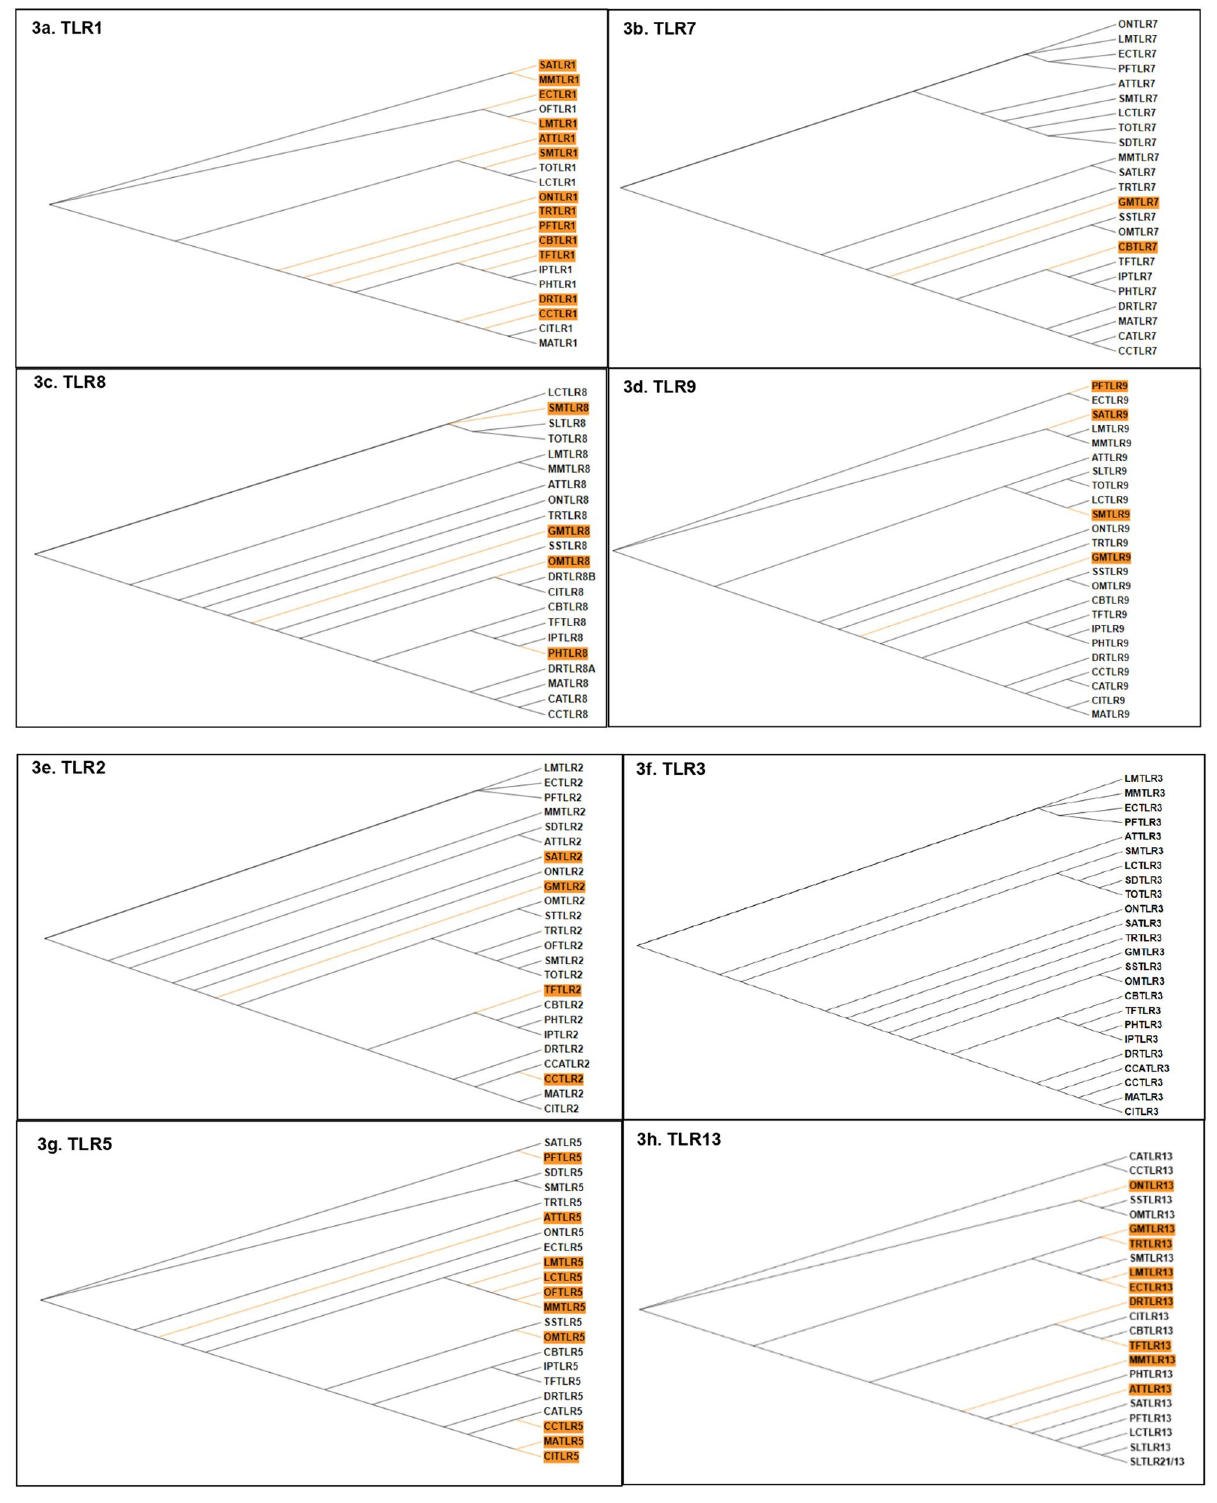
Figure 3. ( a – k ) Detection of the divergent branches (highlighted in orange) on selected TLR1 ( a ), TLR2 ( b ), TLR3 ( c ), TLR5 ( d ), TLR7 ( e ), TLR8 ( f ), TLR9 ( g ), TLR13 ( h ), TLR21 ( i ), TLR22 ( j ) lineages via aBSREL. The clades showing significant divergence for TLR phylogeny are highlighted in orange (p < 0.05). The species are denoted with two letters comprised of the starting alphabets of the genus and species names. (The abbreviation key can be found in Supplementary data 1) TLR1, 5 and 13 have the maximum number of divergent nodes while TLR3 shows none of its clades undergoing divergence. ( k ) Scale of divergence shows G. morhua, L. maculatus, S. maximus and E. coioides to bear the most divergent profile of TLRs, among the teleost TLRs